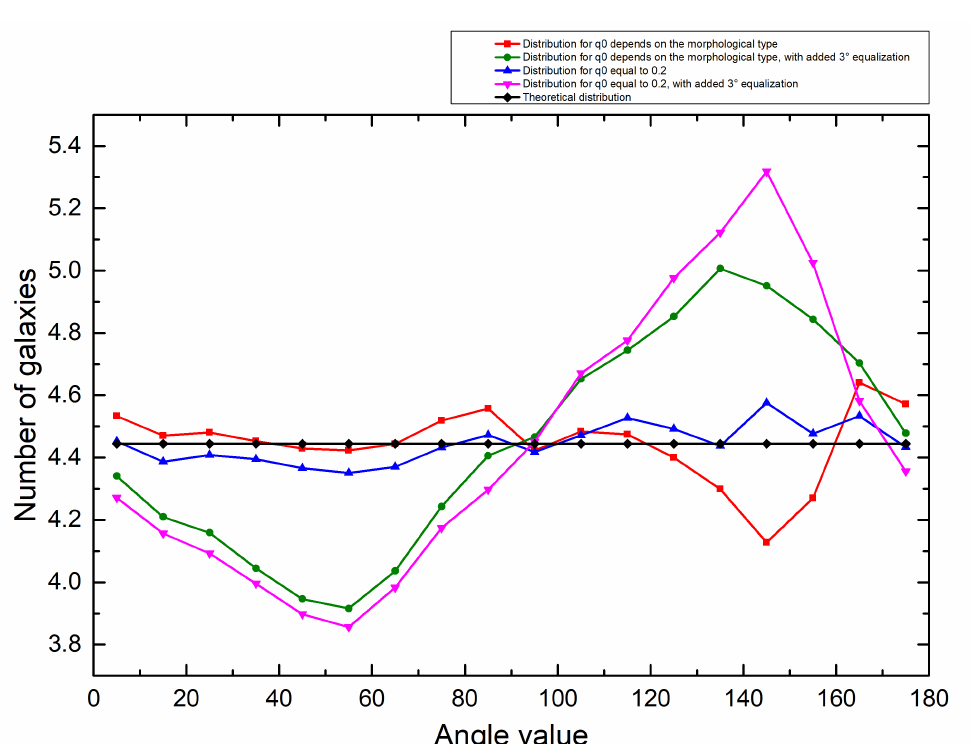
Figure 6. Simulated distributions of the angle η for group